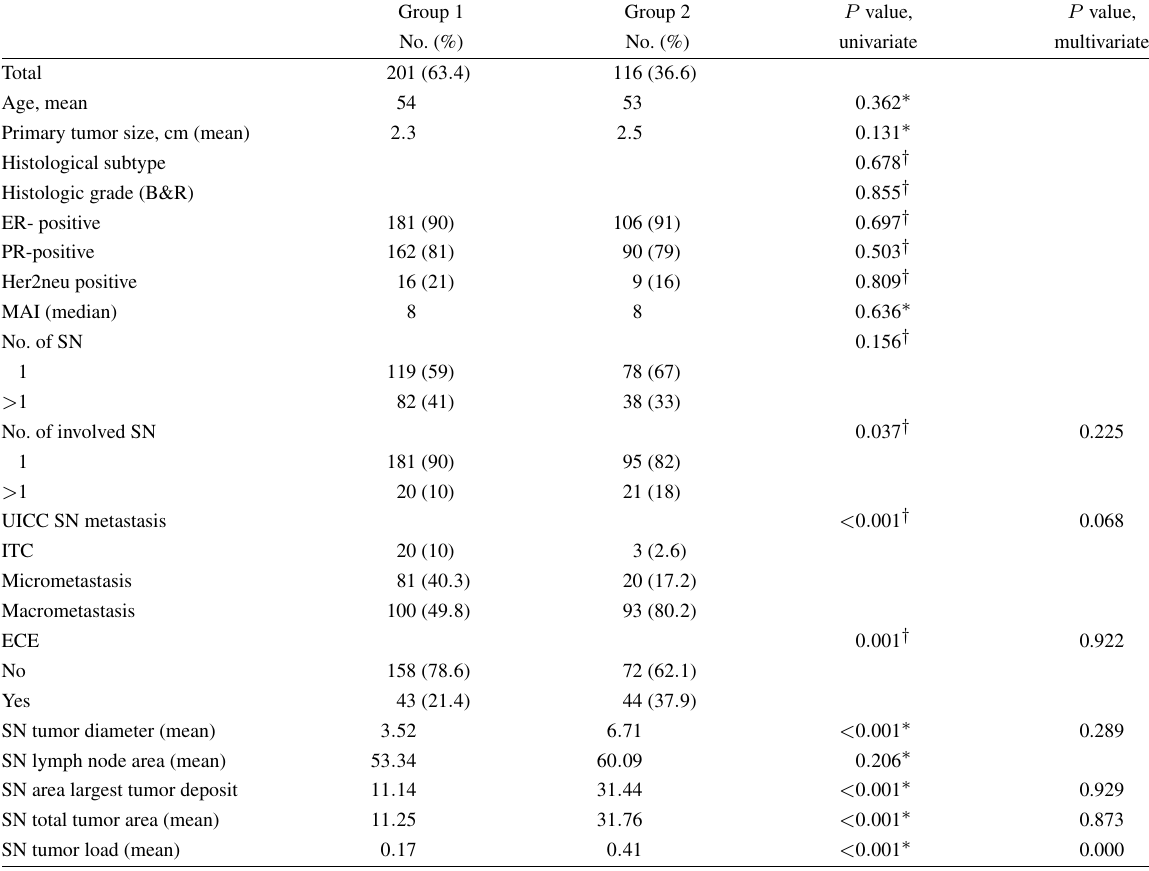
Comparison of clinicopathologic and SN characteristic in invasive breast cancer patients without (group 1) and with second echelon lymph node metastasis (group 2): Univariate and multivariate